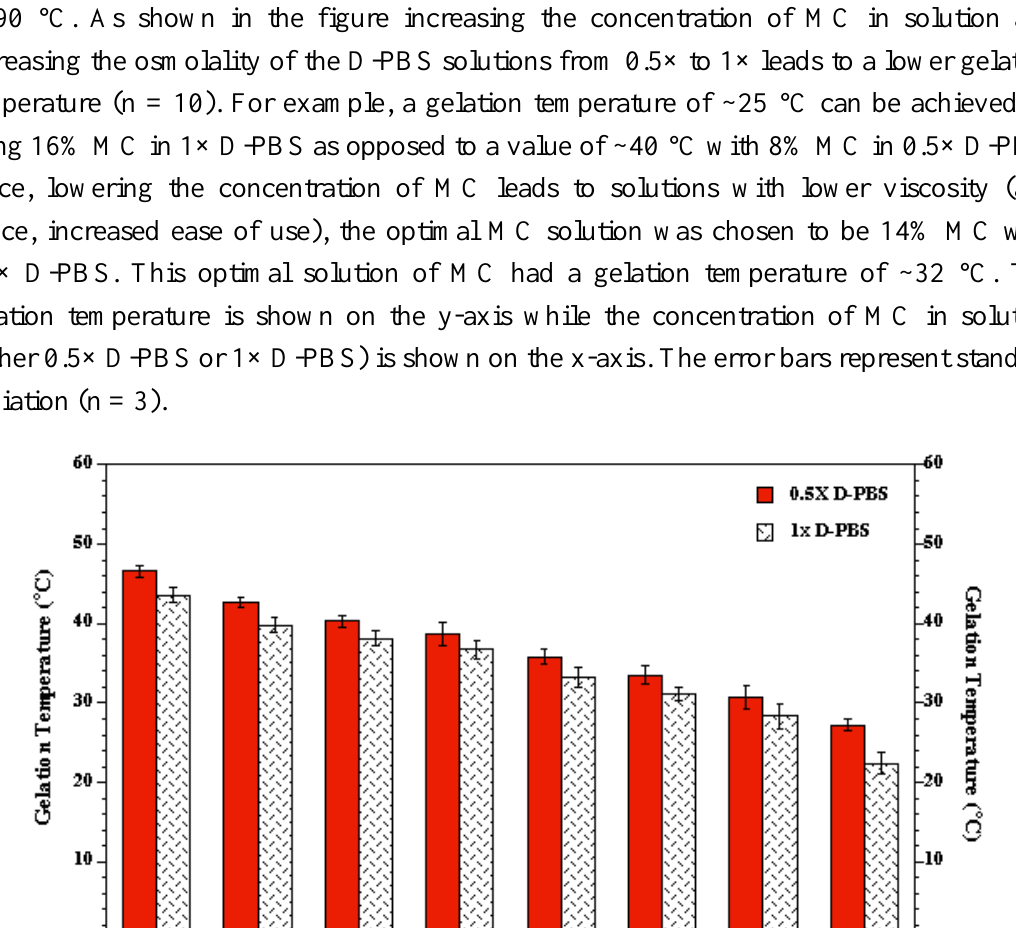
Figure 3. Thermal gelation temperatures of MC M7140 (Mol. wt of 15,000) in 0.5× and